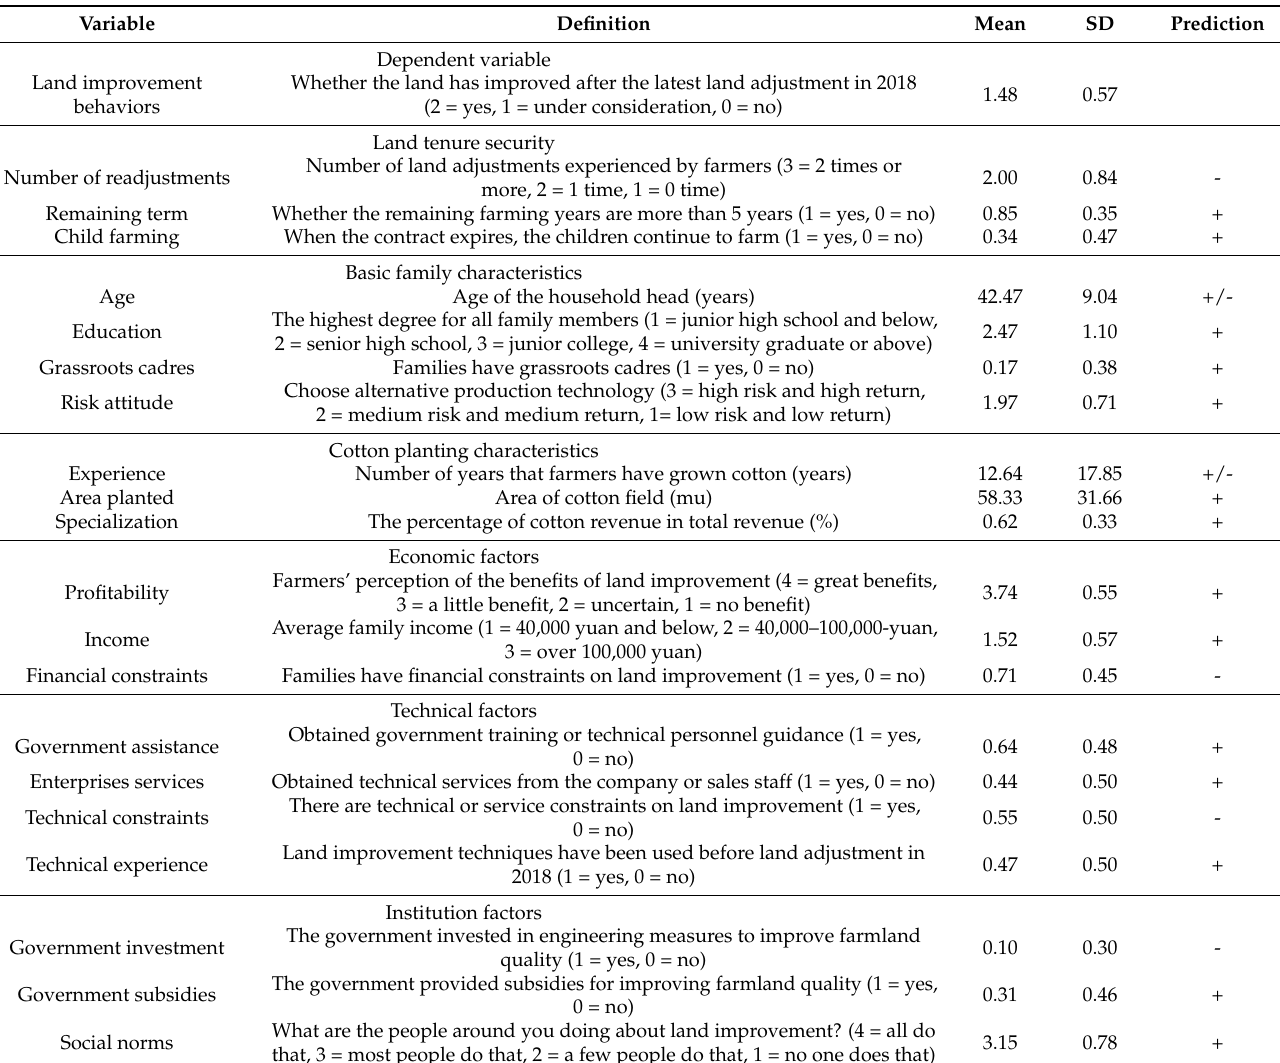
Table 4. Variable Selection, Definition, and